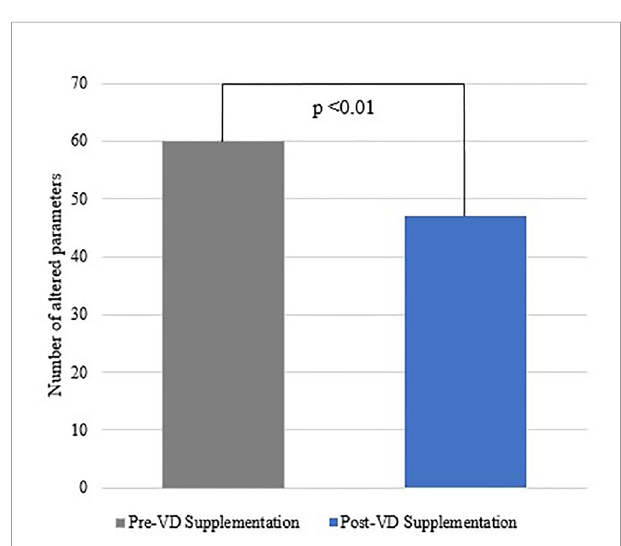
FIGURE 4 | Number of altered frequency domain parameters before and after VD